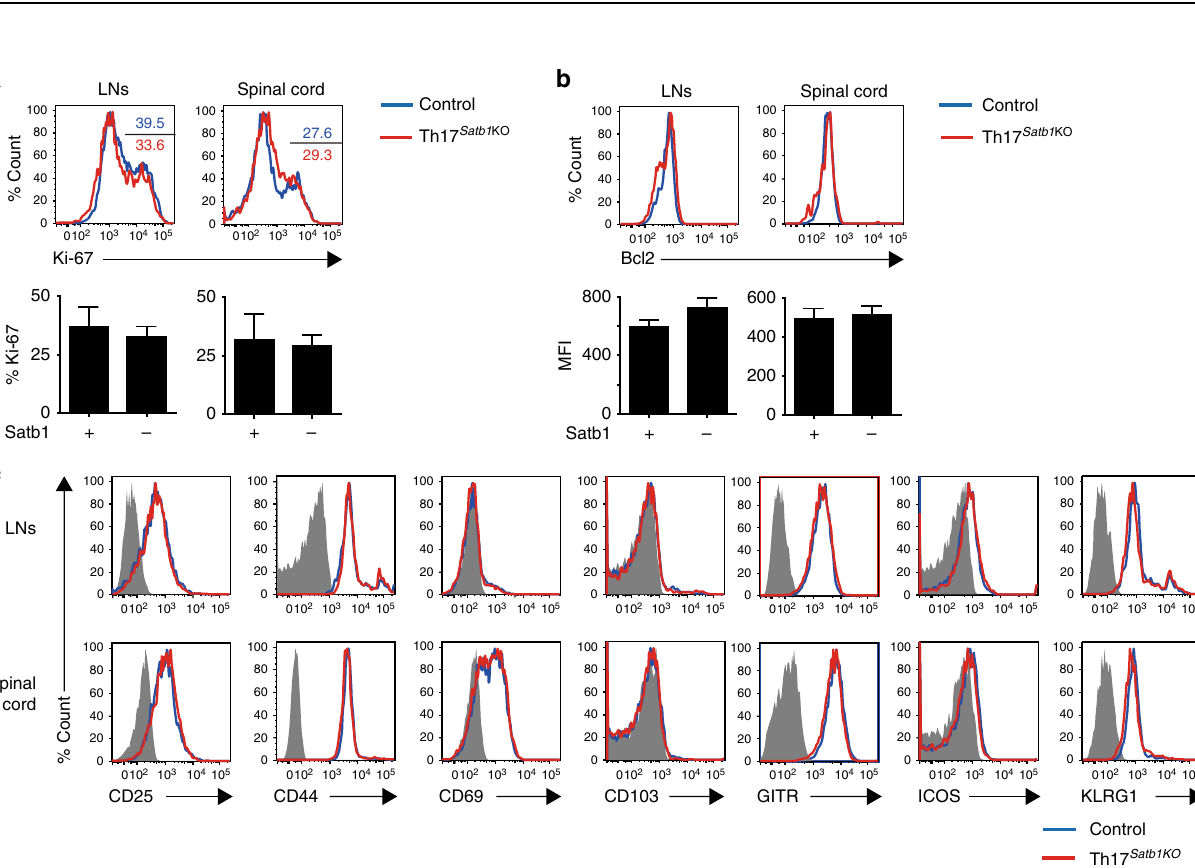
Fig. 3 Comparable activation status between control and Satb1-de fi cient Th17 cells. Flow cytometry of eYFP + CD4 + T cells from the draining LNs and the spinal cord for the expression of Ki-67 ( a ), Bcl-2 ( b ), and CD25, CD44, CD69, CD103, GITR, ICOS, and KLRG1 ( c ) as in Fig. 2d. The frequencies of Ki-67 + ( a ) and the mean fl uorescence intensity (MFI) of Bcl-2 + in eYFP + CD4 + T cells ( b ) are shown. The bar graphs ( a and b ) show the mean ± s.d. ( n = 3). The results are representative of at least three independent experiments ( a – c )